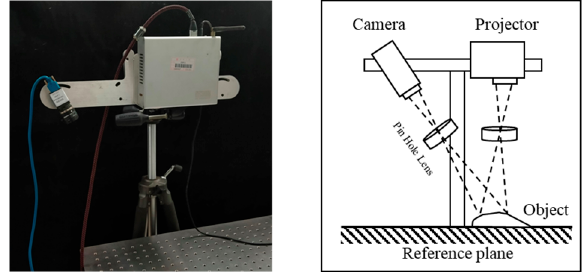
Figure 6. The experimental FPP system.